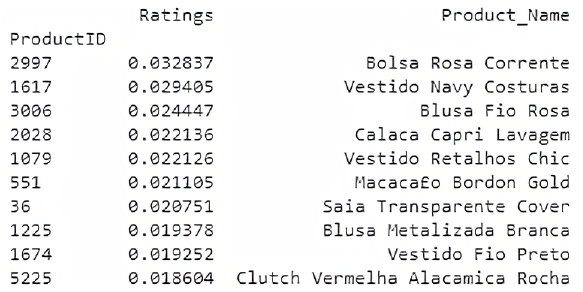
Figure 13. Ten suggestions for products provided by the